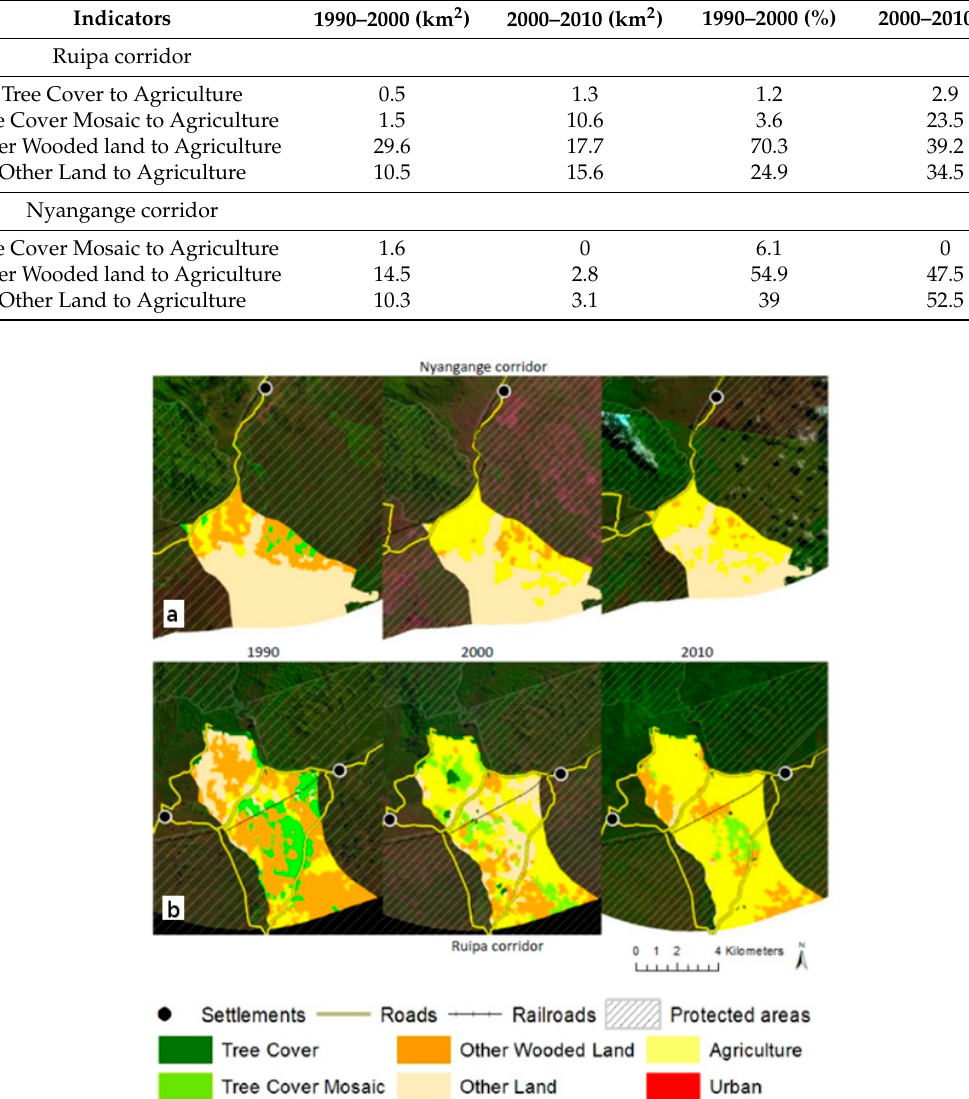
Table 6. Agricultural changes from natural areas in the Ruipa and Nyangange corridor. Km 2 and % from the total of agricultural changes.